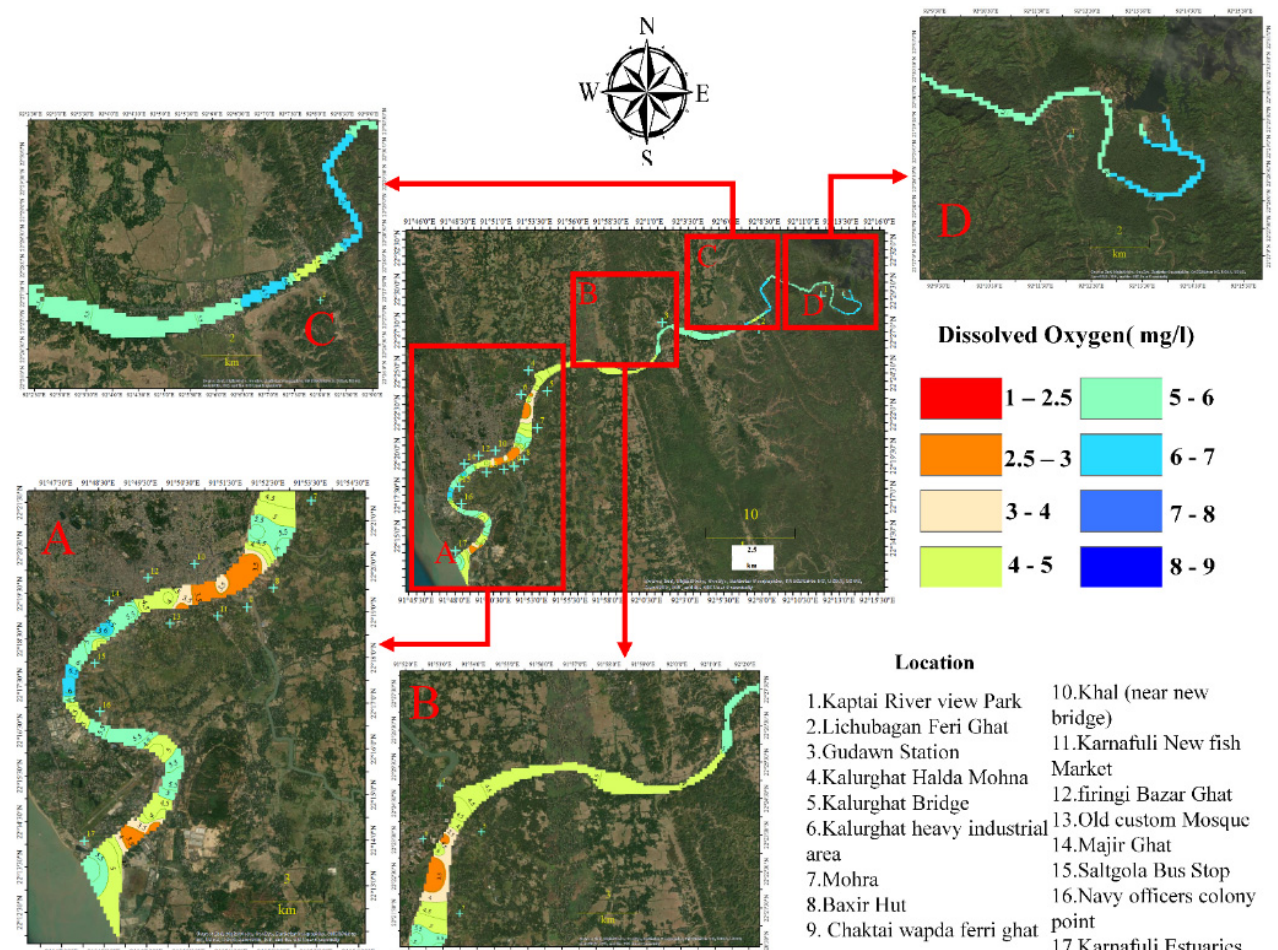
Figure 7. Spatial distribution of dissolved oxygen (Karnafuli River) for better visualization subfigures A-D has been added.